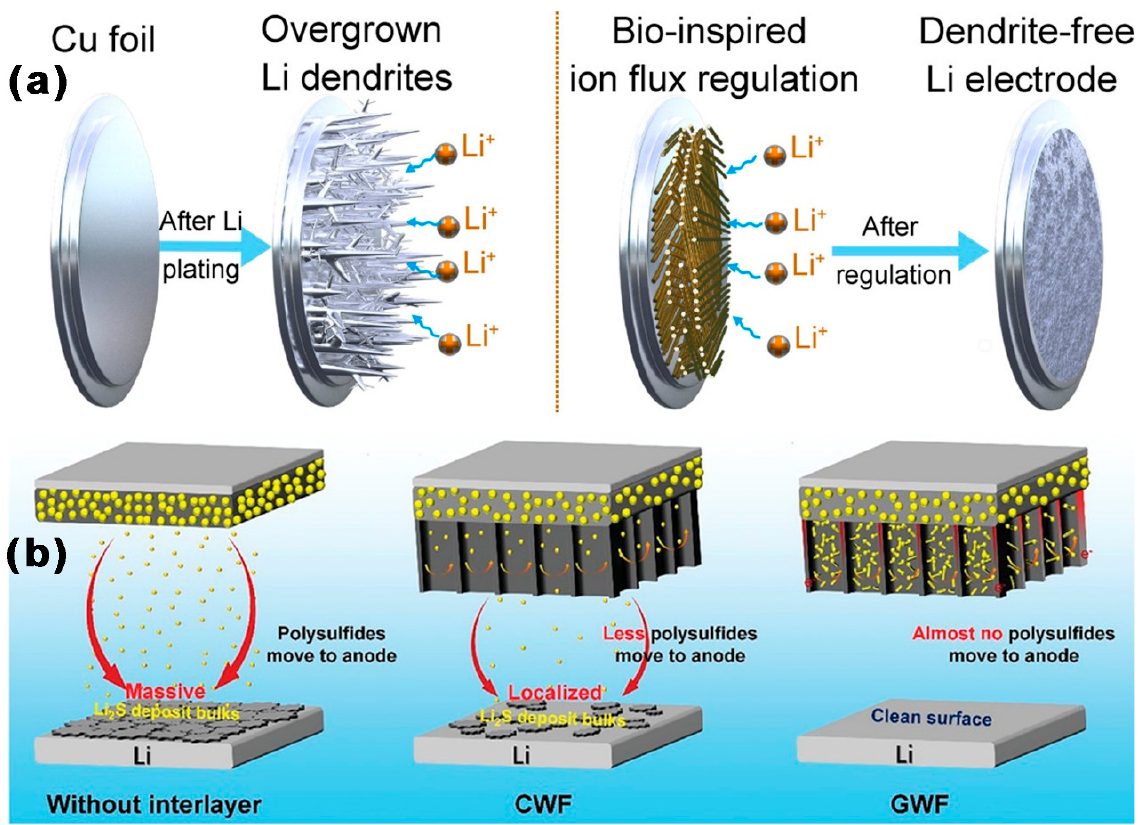
Figure 10. Schematic diagram of Li plating on Li-anode with ( a ) nanowood [88], and ( b ) a GWF interlayer electrode [89].